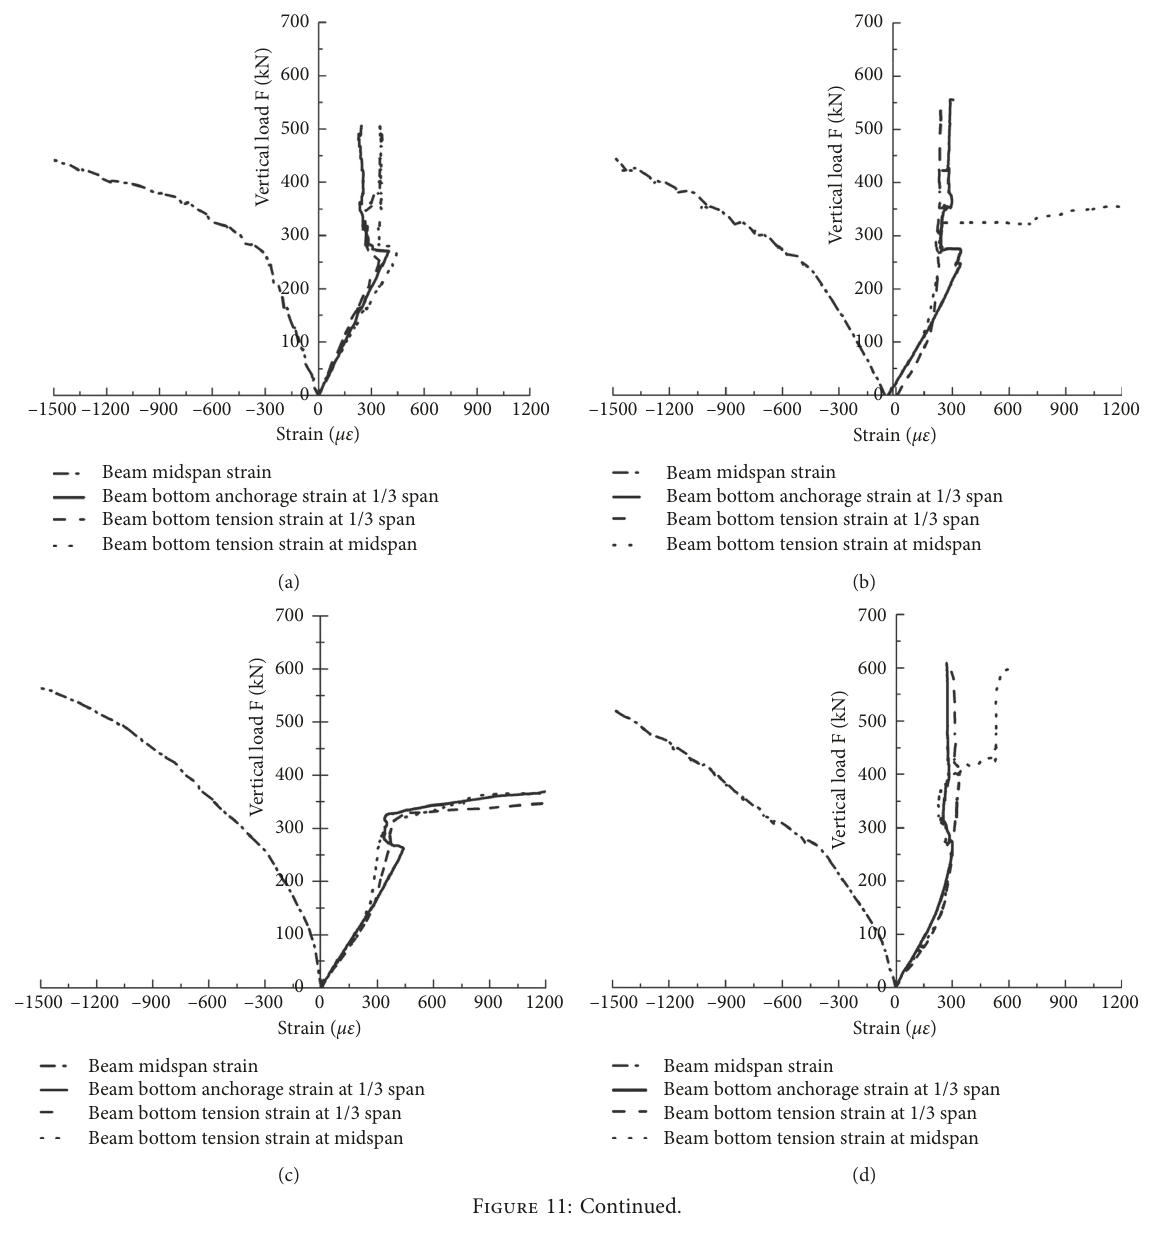
Beam midspan strain Beam bottom anchorage strain at 1/3 span Beam bottom tension strain at 1/3 span Beam bottom tension strain